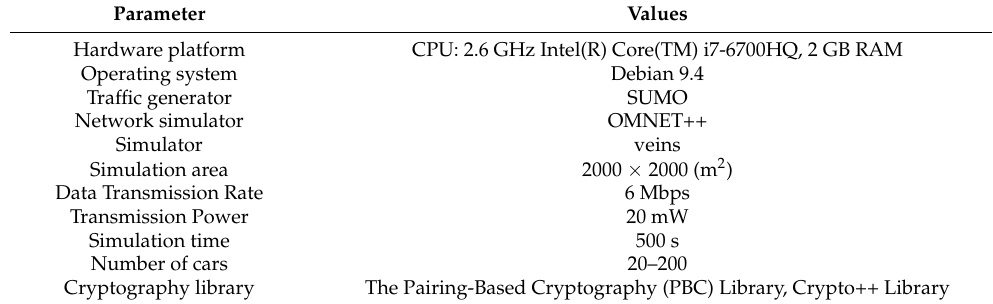
Table 6. Simulation